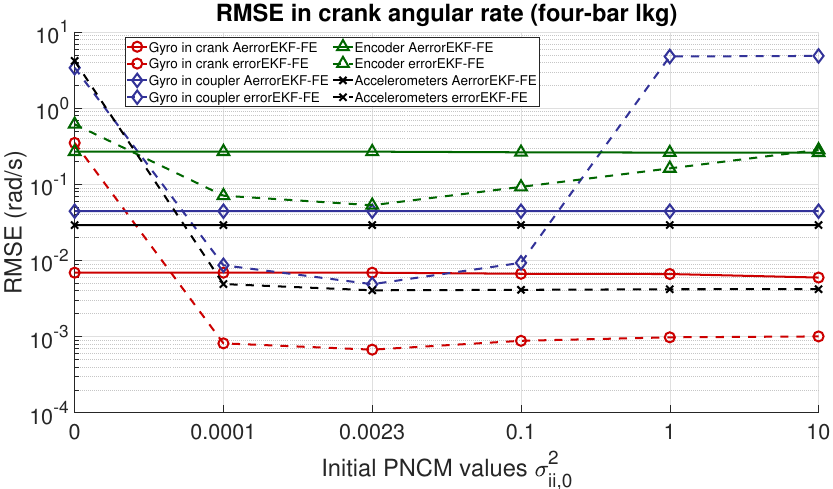
Figure 7. RMSE in the crank angular rate (velocity) provided by the observers for the four-bar linkage.